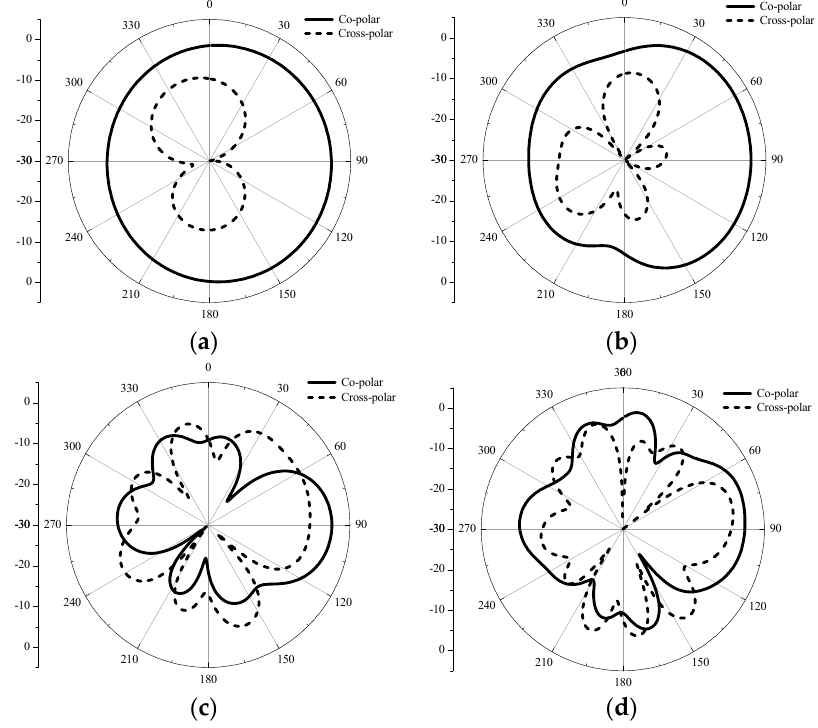
Figure 2. The co- and cross polar pattern at ( a ) 5 GHz, ( b ) 10 GHz, ( c ) 20 GHz, and ( d ) 30 GHz.